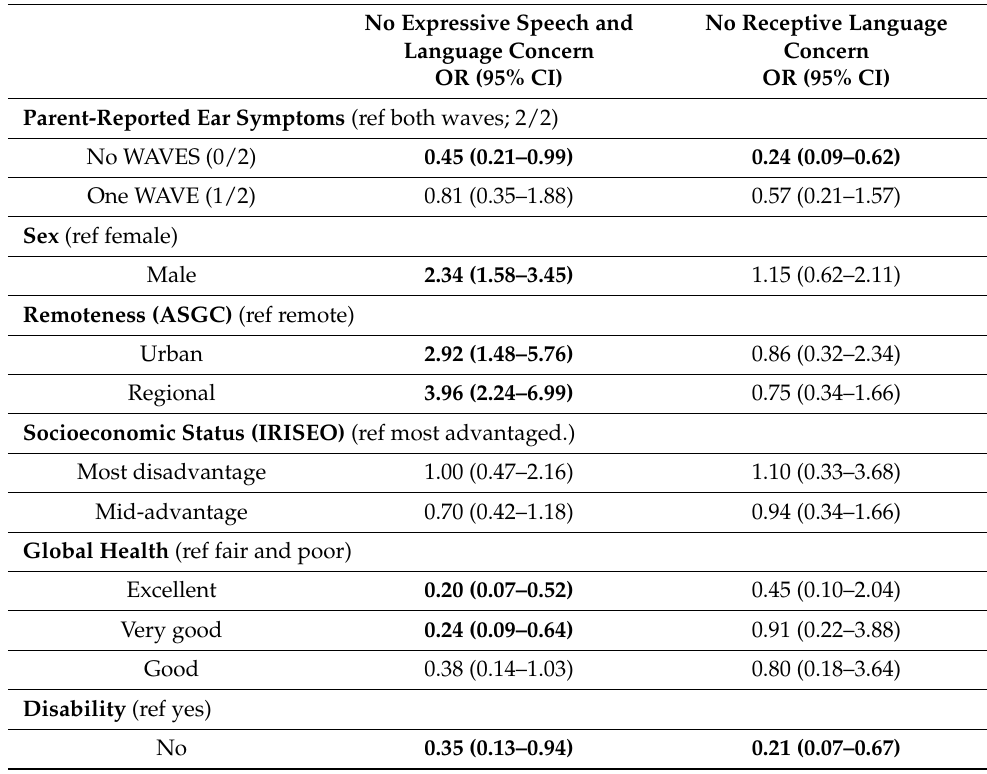
Table 2. No concern for expressive or receptive speech and language with predictor OM variable and covariates with adjusted OR and 95% CI. The reference category for each variable is noted in